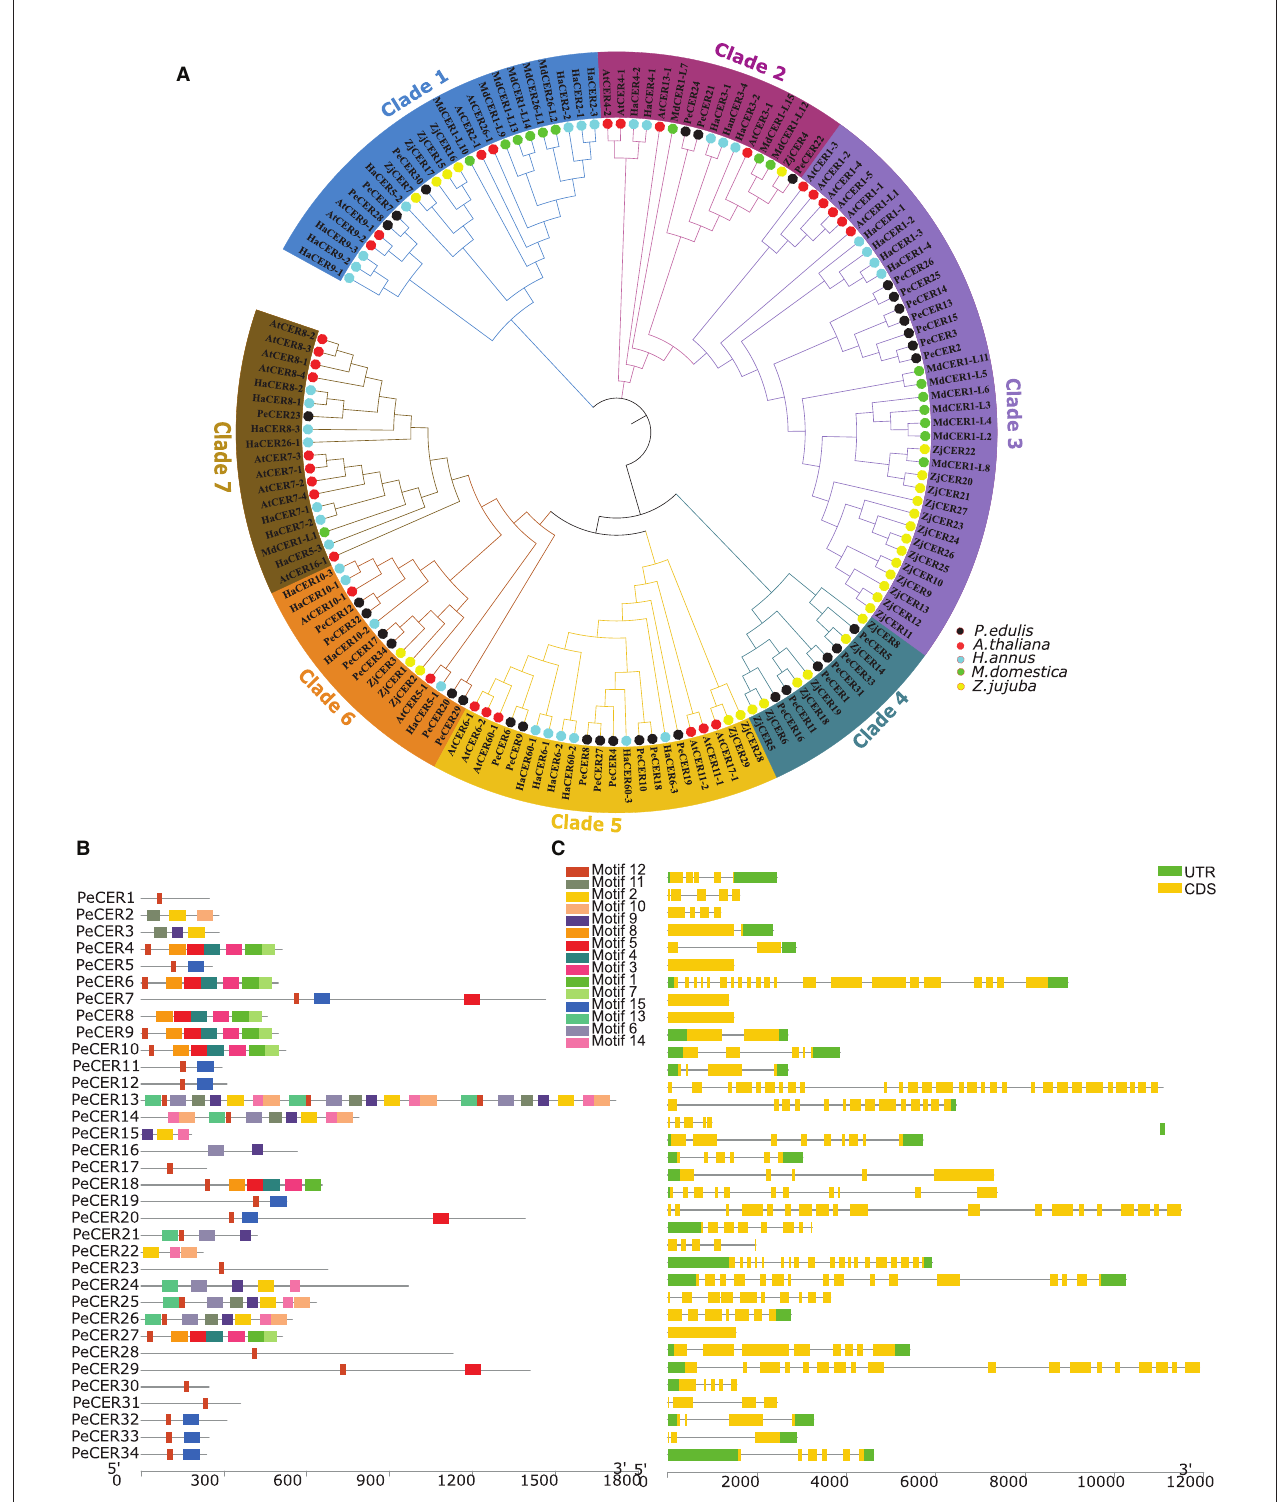
FIGURE 1 | (A) Unrooted neighbor-joining phylogenetic tree among P. edulis, A. thaliana, M. domestica, H. annus, and Z. jujuba CER amino acid sequences with 1,000 bootstraps constructed with MEGA software v10.1.8. The protein sequences of PeCER, AtCER, HaCER, MdCER, and ZjCER are represented by black, red, aqua, green, and yellow color circles, respectively. (B) Conserved motifs were represented via boxes, and different colors represent different motifs. (C) PeCER gene structures; yellow color indicates the exons, green color shows the untranslated 5 ′ and 3 ′ -regions, and gray color indicates the introns.